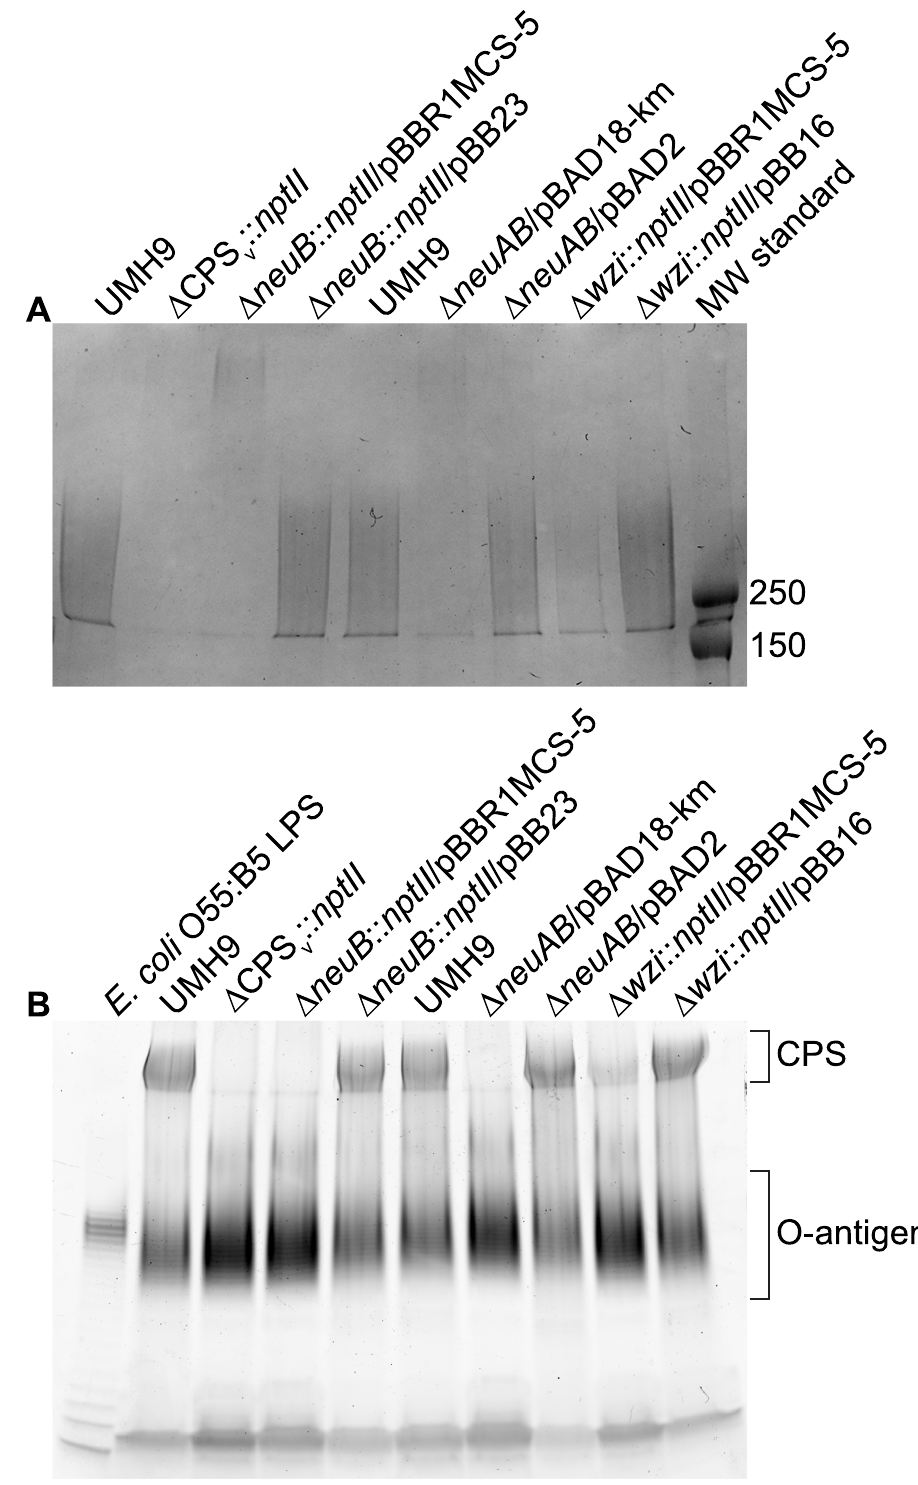
Fig 5. SDS-PAGE of CPS and LPS from S . marcescens mutant strains. Total cell-associated polysaccharides were isolated from S . marcescens strains following overnight culture. (A) Purified polysaccharides were resolved on 7.5% SDS-PAGE gels and visualized by Alcian Blue staining. The molecular weights (kDa) of pre-stained protein standards (MW standard) are indicated. (B) Total cell-associated polysaccharides were electrophoresed on 4–20% gradient